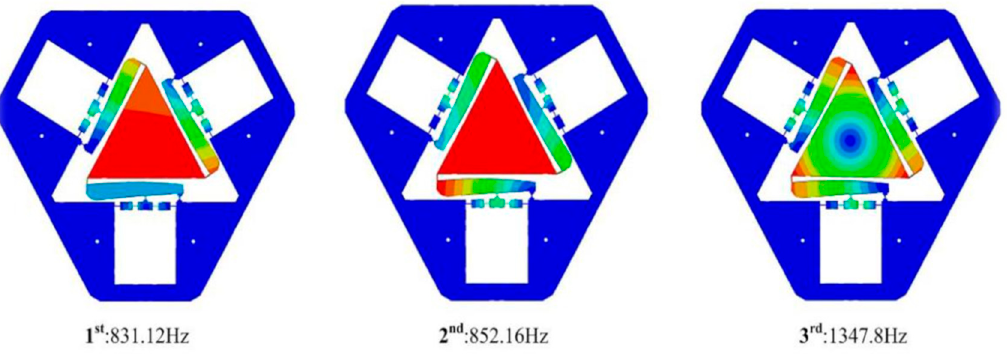
Figure 10. Mode shapes of the developed VPD.